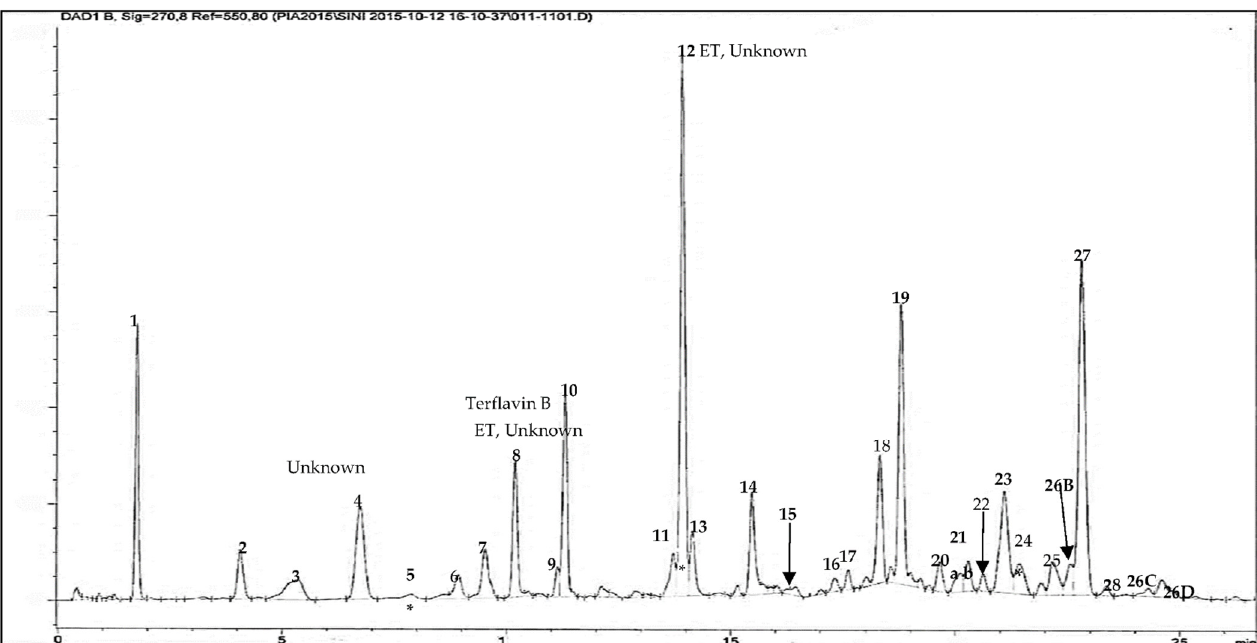
Figure 3. HPLC-DAD chromatogram at 270 nm of an ethyl acetate fraction of the leaves of T. brownii . ( 1 ), gallic acid; ( 2 ), protecatchuic acid; ( 3 ), unknown compound; ( 4 ), 1,3-di-galloyl- β -D-glucose; ( 5 ), unknown ellagitannin; ( 6 ), isomer of methyl-( S )-flavogallonate; ( 7 ), unknown compound; ( 8 ), unknown ellagitannin [M-H]- 541.0291; ( 9 ), 1,6-di-galloyl- β -D-glucose; ( 10 ), terflavin B; ( 11 ), methyl gallate; ( 12 ), uknown ellagitannin [M-H]- 617.0164; ( 13 ), 1,2,3-tri- О -galloyol- β -D-glucose; ( 14 ), gallotannin; ( 15 ), corilagin; ( 16 ), luteolin-7- O -glucoside; ( 17 ), gallotannin; ( 18 ), 3,4,6-tri- О -galloyol- β -D-glucose; ( 19 ), di- O -galloyl derivative (Maplexin D) [M-H]- 467.0802; ( 20 ), apigenin; ( 21a ), 1,2,3,6-tetra- O -galloyl- β -D-glucose; ( 21b ), unknown gallotannin; ( 22 ), kaempferol-4 ′ -sulfate [M-H]- 365.2928; ( 23 ), di-methyl ellagic acid glucoside; ( 24 ), myricitin-3-rhmanoside; ( 25 ), gallotannin; ( 26B ), unknown flavonoid; ( 26C ), uknown flavonoid; ( 26D ), unknown flavonoids; ( 27 ), gallotannin of chebulinic acid (Eutannin); ( 28 ), gallotannin; *, is the exact peak for the detected compounds.